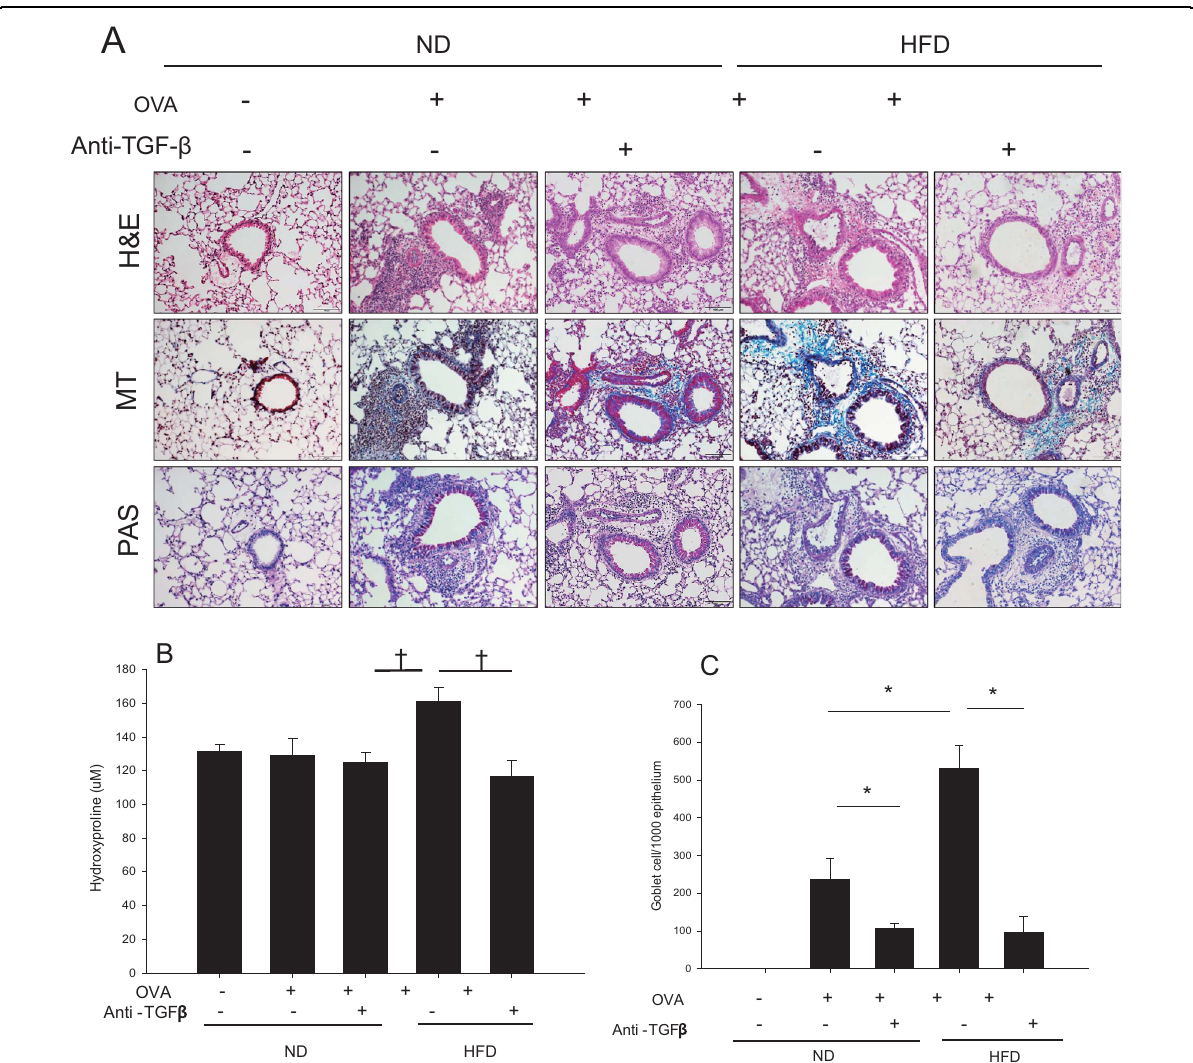
Fig. 6 Histological features of the lung tissue from OVA-HFD and OVA-ND mice given anti-TGF- β mAb treatment. H&E, PAS, and MT staining features ( a ) are shown at ×200 magni fi cation. The collagen content in lung homogenates was measured by a hydroxyproline assay ( b ), and the quanti fi cation of goblet cell hyperplasia measured by PAS staining ( c ) in various murine models after the inhibition of TGF- β is shown. † P < 0.05, * P < 0.001. HFD high-fat-diet, TGF transforming growth factor, H&E hematoxylin and eosin, PAS periodic acid-Schiff, MT Masson ’ s